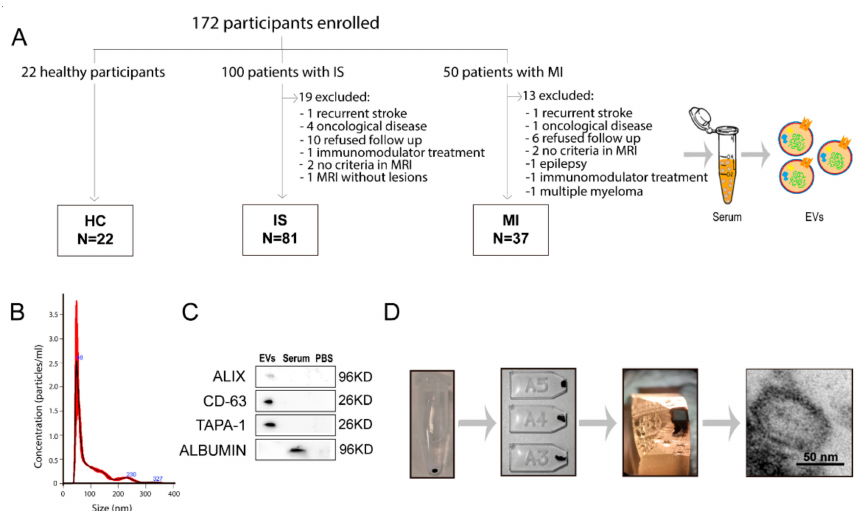
Figure 1. Collection and analysis of extracellular vesicles. ( A ) The number of patients from whom serum EVs were isolated. Characterization of EVs by size ( B ), EV phenotype by western blot ( C ) and their morphology by electron microscopy ( D ). Abbreviations: EVs, extracellular vesicles; HC, healthy controls; IS, ischaemic stroke; MI, myocardial infarction; MRI, magnetic resonance imaging; PBS, phosphate buffered